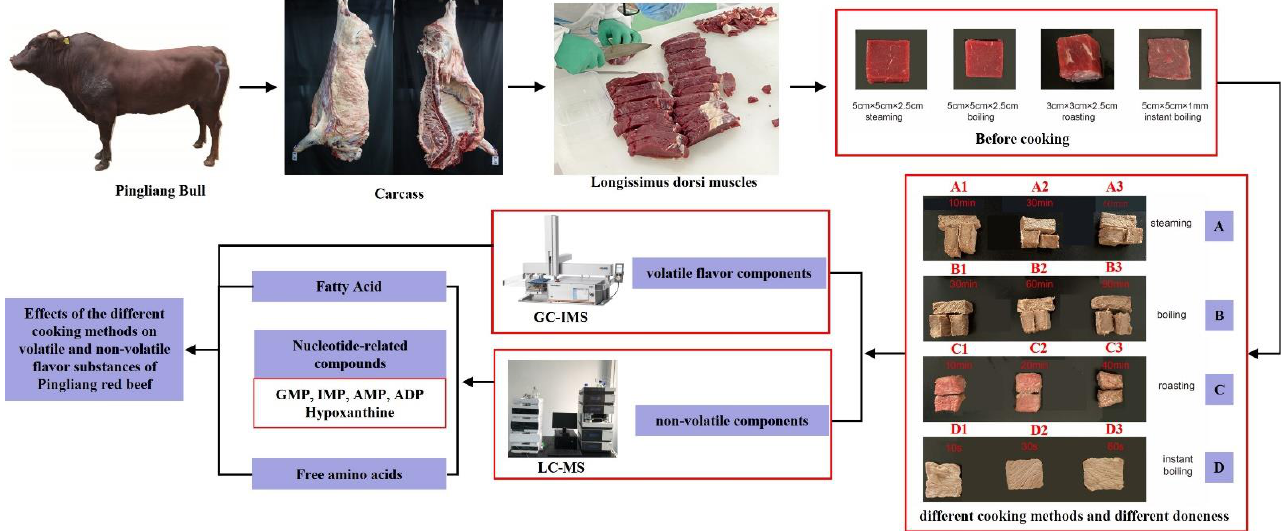
Figure 1. Experimental design of Pingliang red beef under different cooking methods. Table 1. Information on the Pingliang red beef samples and their cooking methods.